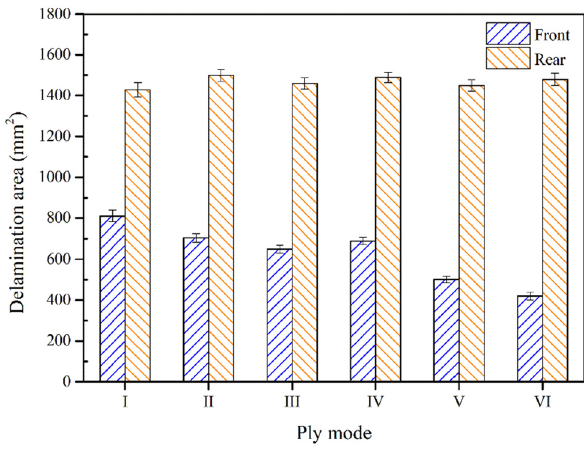
Figure 5: Delamination areas of the failure specimens.